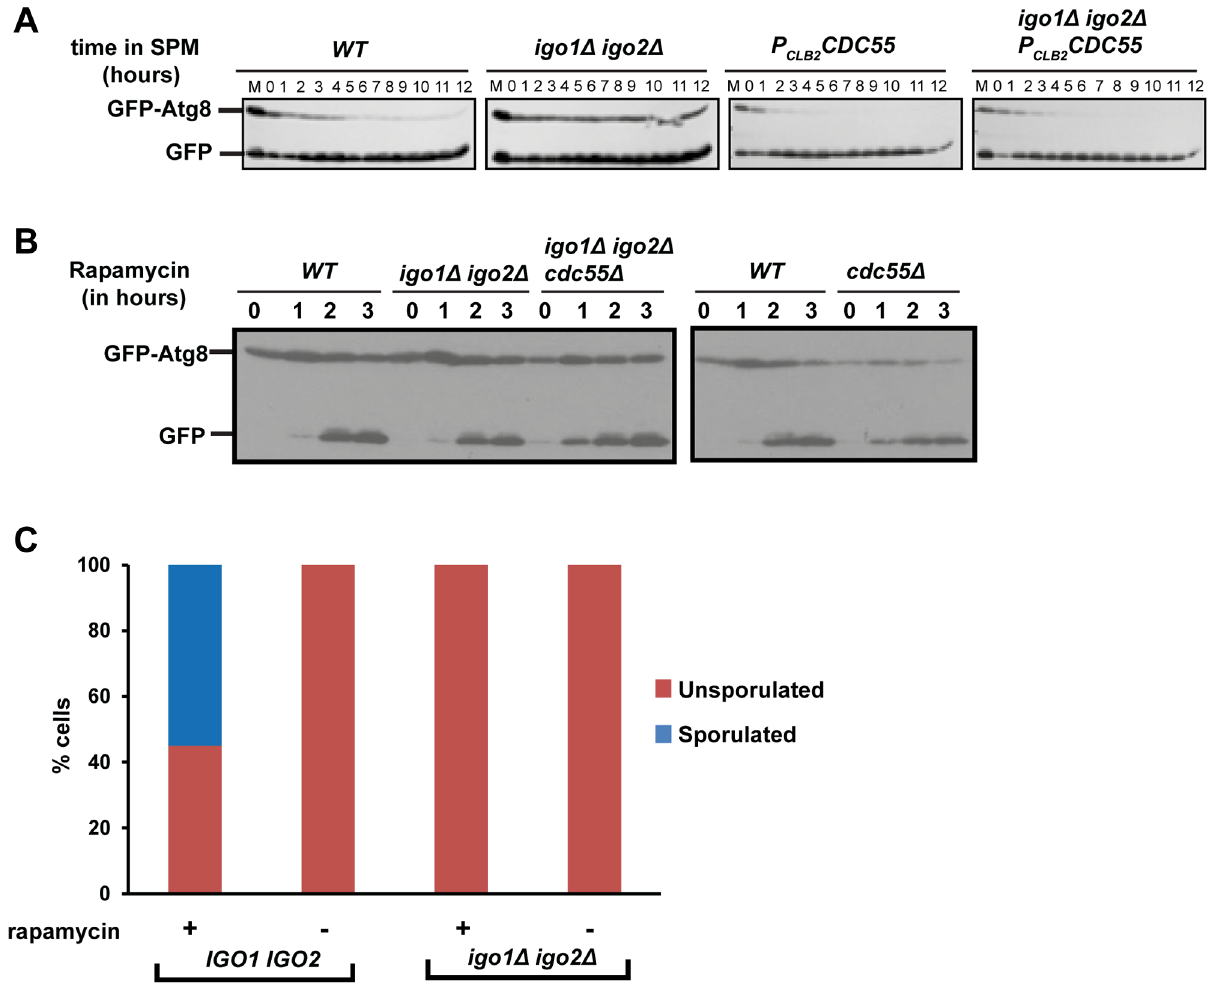
Figure 7. Endosulfine mutant is defective in pre-meiotic autophagy but not for autophagy induced by rapamycin treatment. A) Wild type, P CLB2 CDC55 , igo1 D igo2 D and igo1 D igo2 D P CLB2 CDC55 cells expressing GFP-Atg8 were induced to sporulation. Samples were collected at indicated times and total cell extract was prepared. Western analysis was performed using anti-GFP antibody. B) Wild type, cdc55 D , igo1 D igo2 D and igo1 D igo2 D cdc55 D cells expressing GFP-Atg8 were grown to log phase in YEPD and rapamycin (final concentration 200 ng/ml) was added to the cultures. The cultures were incubated further for 3 hours. Cells were collected at indicated time points, total protein extract was prepared and immunoblot analysis was performed using anti-GFP antibody. C) Wild-type, igo1 D igo2 D cells were grown to saturation in YEPD, rapamycin (final concentration 200 ng/ m l) was added to the culture and grown for another 24 hours. Sporulation efficiency was measured by counting the total number of monad, dyad and triads/tetrads in the culture (n=200).